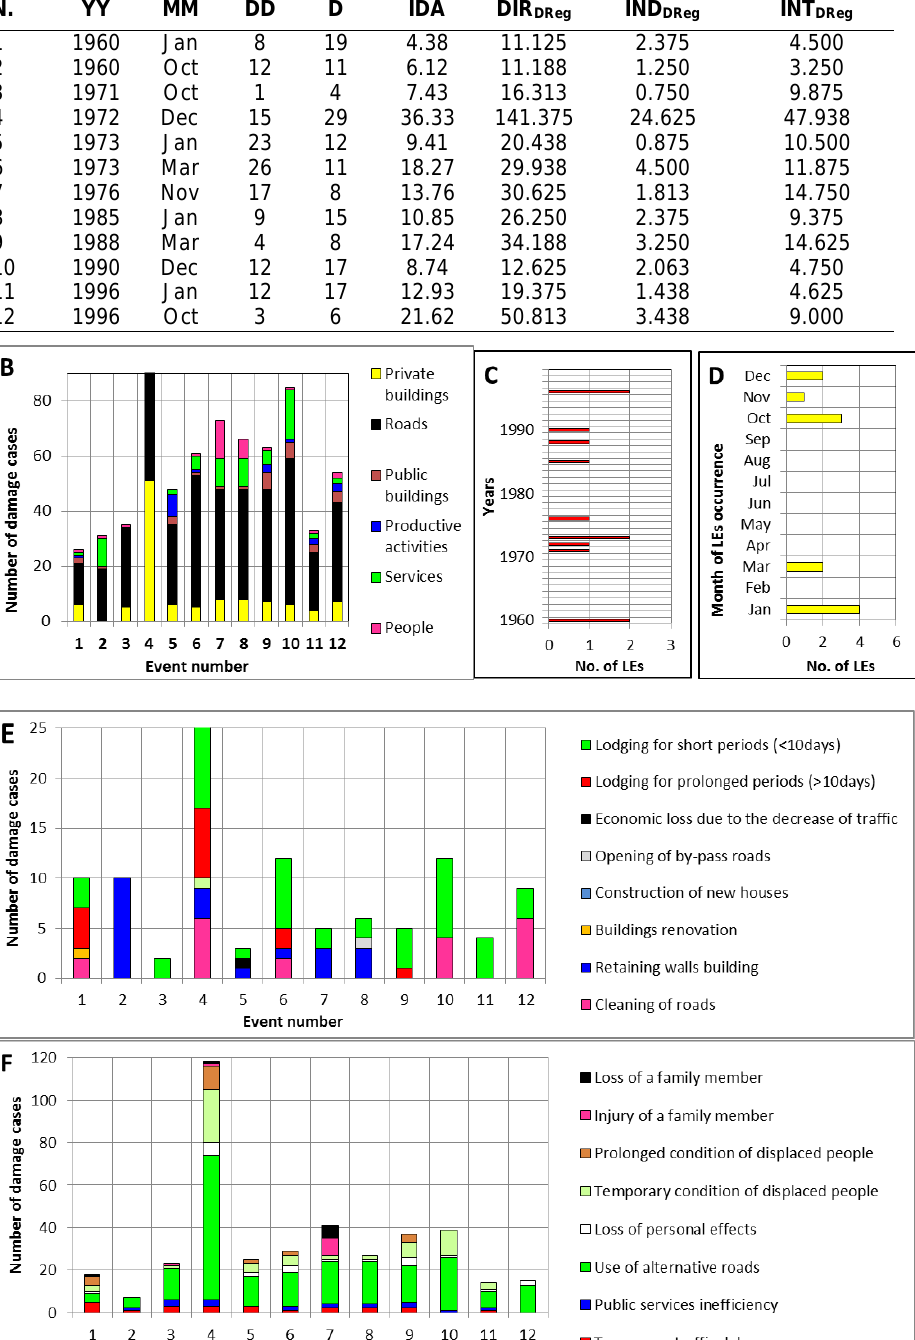
), indirect (IND ) 5 Dreg DReg